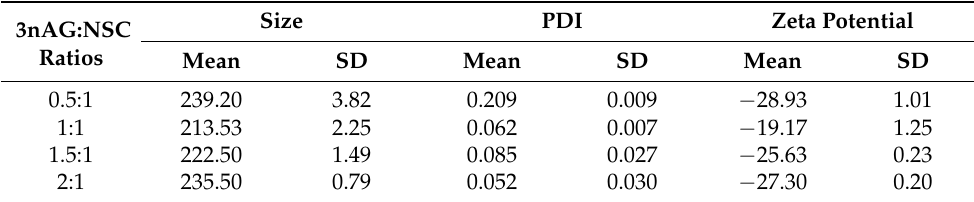
(Figure 1b). The 3nAG:NSC ratios of 1.5:1 and 2:1 were optimal for 3nAGN preparation, providing a good percentage yield even after sterilizing with an autoclave. Therefore, 3nAGN-NSC prepared at the 3nAG:NSC ratio of 1.5:1 was selected for further experiments. Table 2. The particle size, polydispersity index (PDI), and zeta potential of 3nAGN prepared with different ratios of 3nAG:NSC. All data represent the mean ± standard deviation (n =